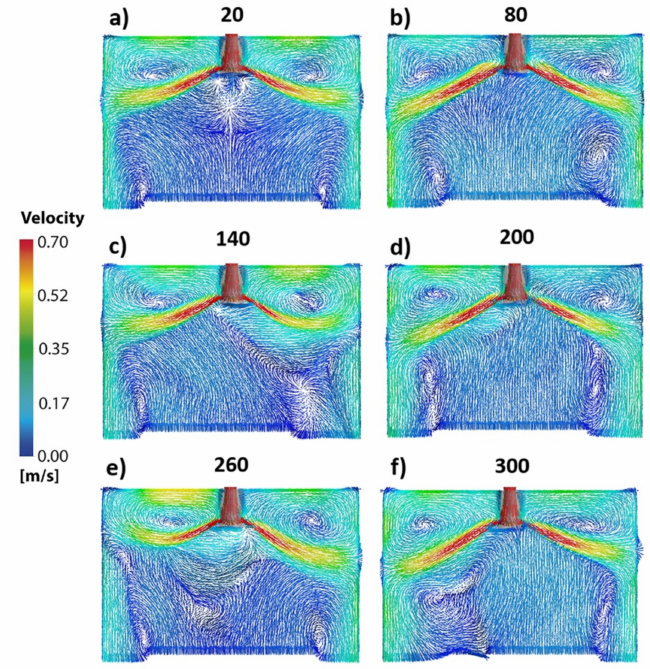
Figure 11. Numerical velocity fields in the central plane of the mold using nozzle A without clogging at different times. ( a ) 20 s. ( b ) 80 s. ( c ) 140 s. ( d ) 200 s. ( e ) 260 s. ( f ) 300